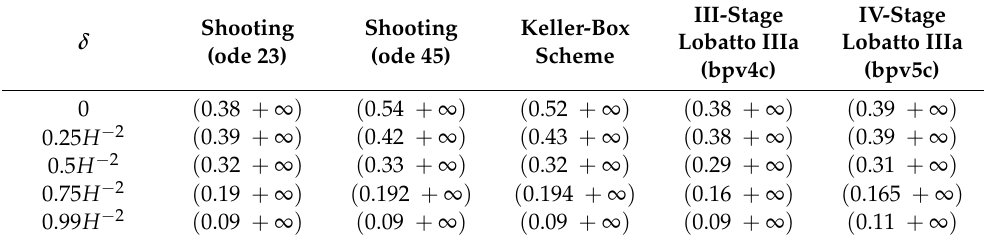
Table 1. Ranges of θλ 2 ensuring convergence when numerical procedures are applied.